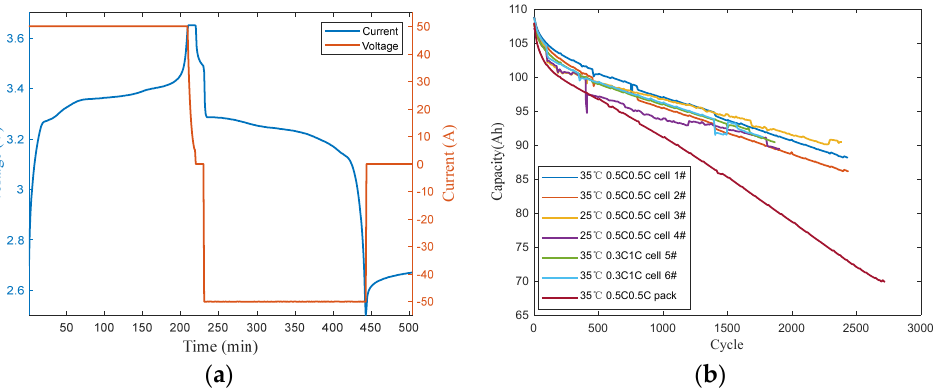
Figure 8. Battery cycling profile and capacity aging curves: ( a ) voltage and current curves in a charge–discharge cycle; ( b ) capacity decay curves of battery cells and